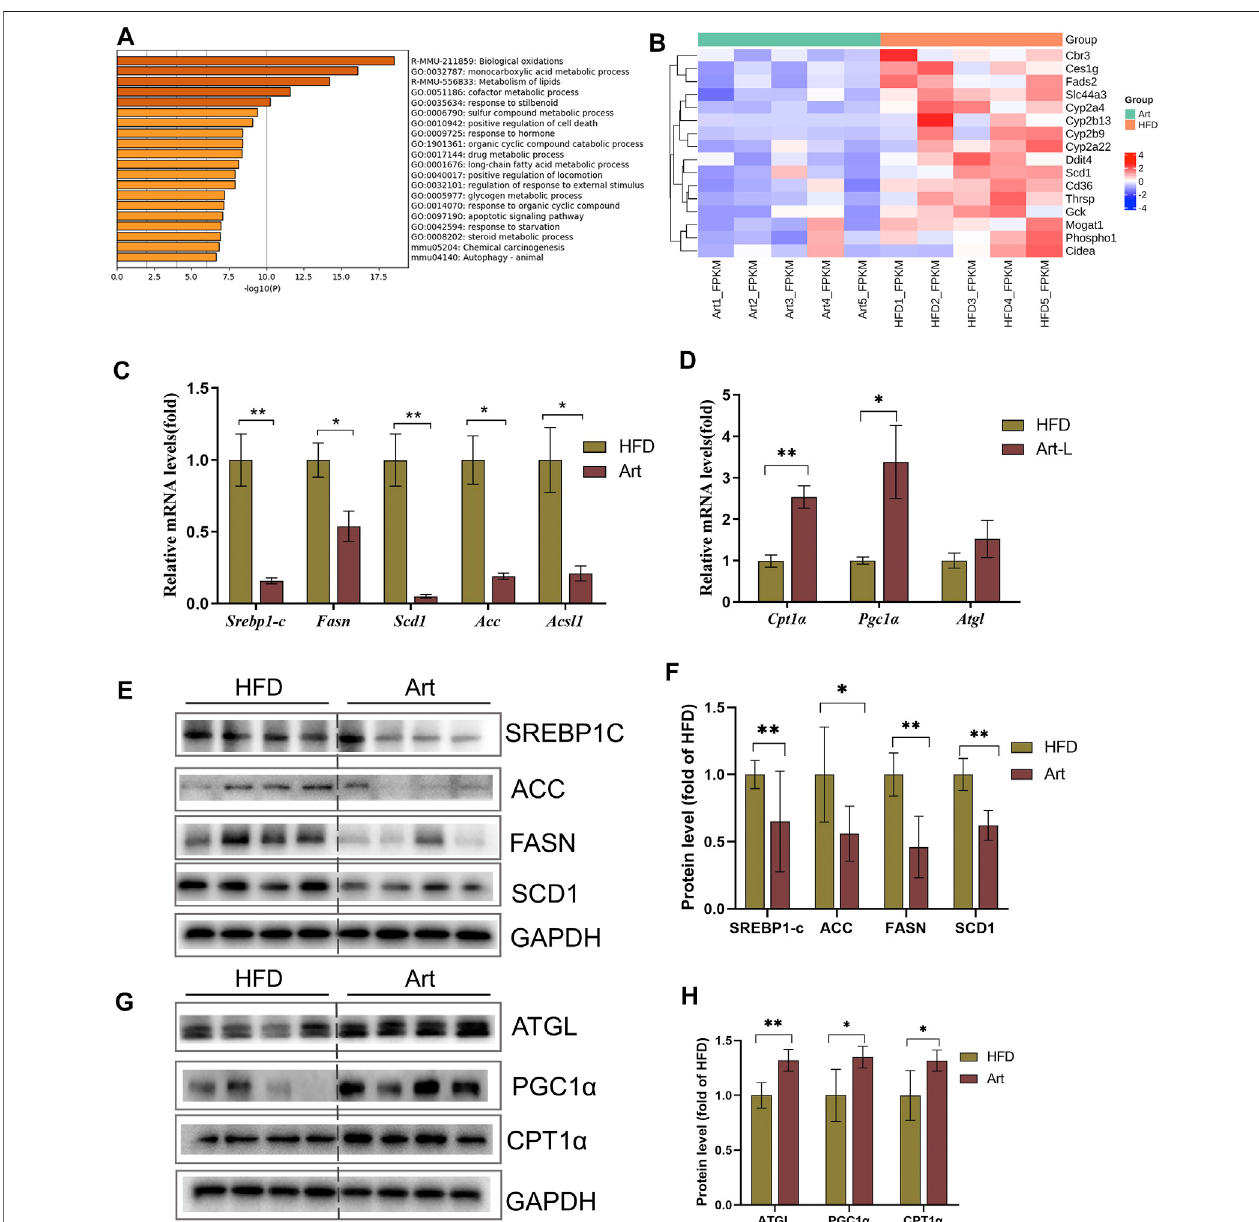
FIGURE 3 | Effect of artemether treatment on the liver lipid metabolic pathway in NASH mice induced by an HFD. (A) KEGG pathway enrichment of the differential gene. (B) Heatmapofthefreefattyacidmetabolism-relatedgene. (C,D) Real-timePCRanalysisoflipidsynthesis-relatedgenes (C) andlipolysis-relatedgenes (D) inthe liver. (E – H) Expression and quanti fi cation analysis of lipid synthesis-related protein (E,F) and lipid breakdown-related protein (G,H) in the liver were detected bywestern blot. * p < 0.05, ** p < 0.01, and *** p < 0.001.